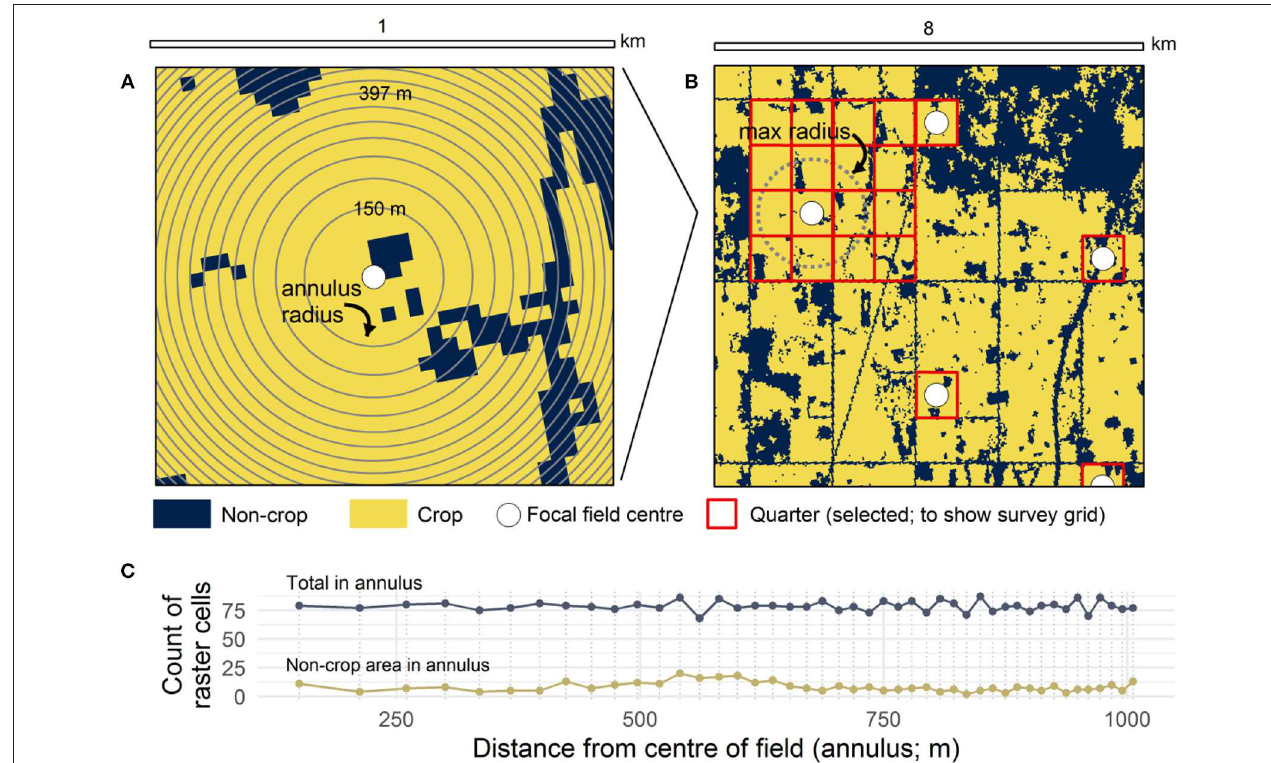
FIGURE 1 | Illustration of the multi-scale method for measuring the proximity of non-crop land covers to field centers. (A) Forty-five annuli of decreasing radii, but approximately equal area, are measured from each field center; (B) Field centers are positioned at the center of quarter sections, the spatial unit that describes most fields in the region, and spaced a minimum of 2.5km apart; (C) Counts of non-crop area raster cells and the total number of cells in each annulus in A used to find proportional cover. Non-crop raster cells are counted in the smallest annulus in which they fall.